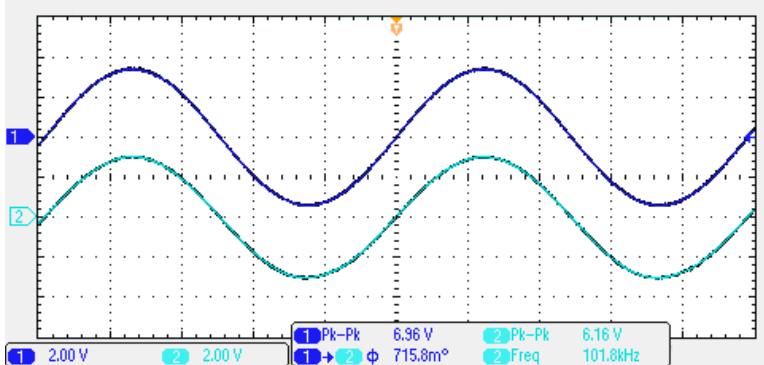
Figure 15. The experimental results of input (channel 1, blue line) and output (channel 2, cyan line) time-domain experimental voltage waveforms.